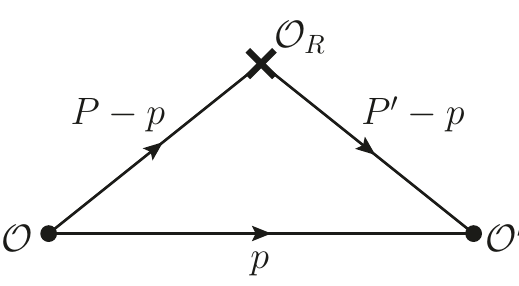
0 V , demonstrating the (cid:13)ow hOj jO i